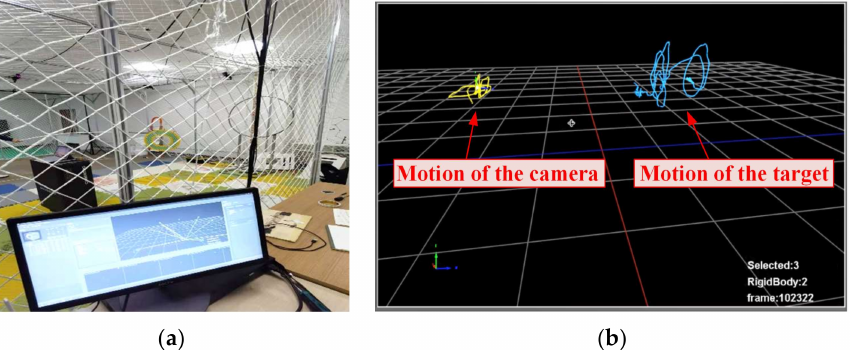
Figure 12. Measurement of indoor environment: ( a ) Motion capture system monitoring station perspective; ( b ) Visual interface of the motion capture system.